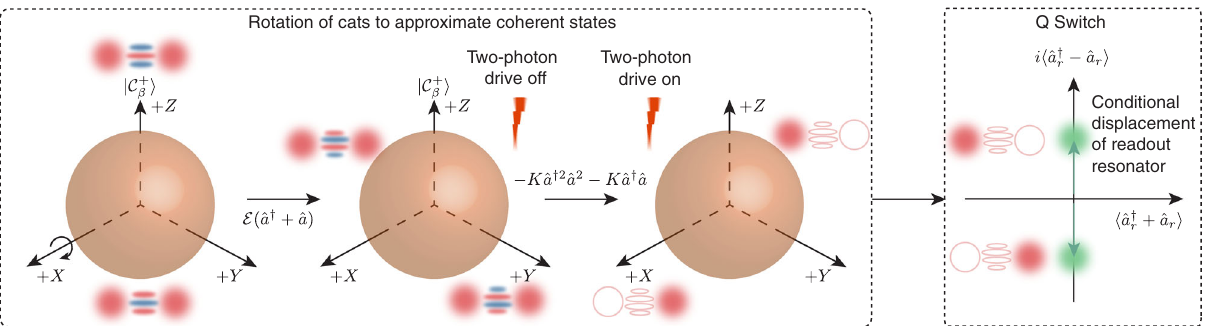
FIG. 9. The figure shows an overview of the ancilla cat ’ s readout cycle. After mapping the error syndrome, the state in the PCO is either j C þ β i or j C − β i . These are first rotated around the X axis to the states ðj C þ β i (cid:3) i j C − β iÞ = turned off, and free evolution under the Kerr nonlinearity rotates ðj C þ β i (cid:3) i j C − β iÞ = two-photon drive is turned on such that the cat subspace C is again stabilized against rotations around the Y axis or Z axis. The next step is to switch on the single-photon exchange coupling between the PCO and a low- Q readout oscillator. This Q -switch operation displaces the readout oscillator conditioned on if the PCO is in a coherent state j β i or j − β i . Finally, a homodyne detection of the field at the output of the readout reveals the state of the PCO, thereby extracting the error